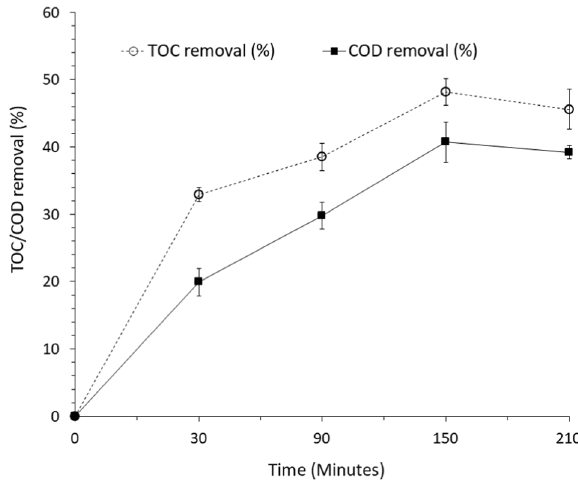
Fig. 3 TOC removal (%) and COD removal (%) at TiO 2 dosage 0.45g/L , ZnO dosage 0.45g/L , H different solar irradiation